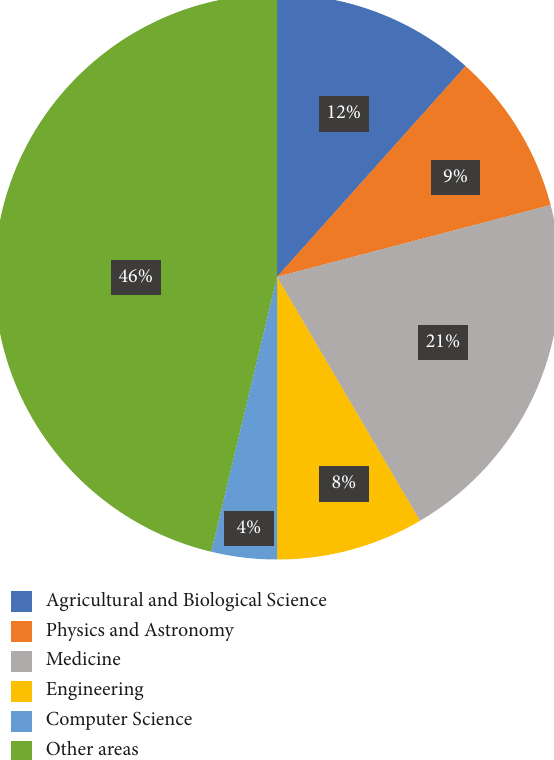
Figure 4: Percentage of relevant topic areas in